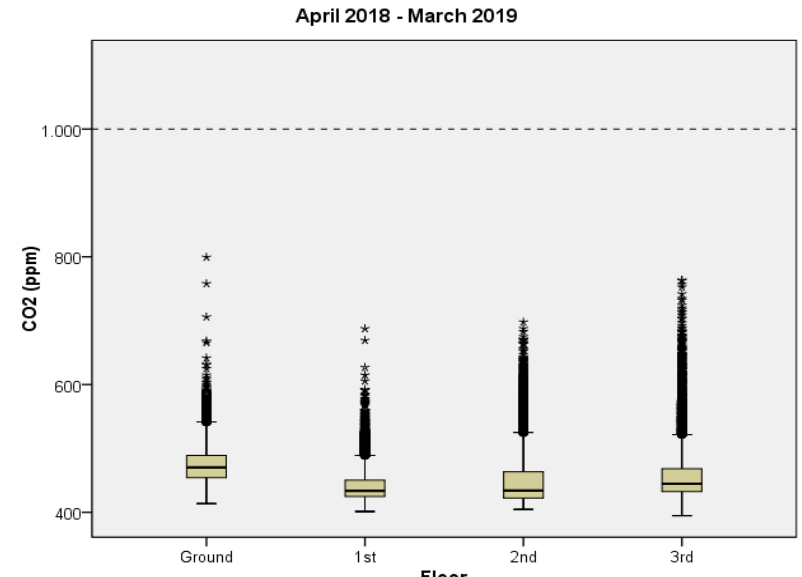
Figure 6. Boxplots of CO 2 within each floor, for all experimental periods (April 2018 – March 2019), along with the respective limit of exposure.